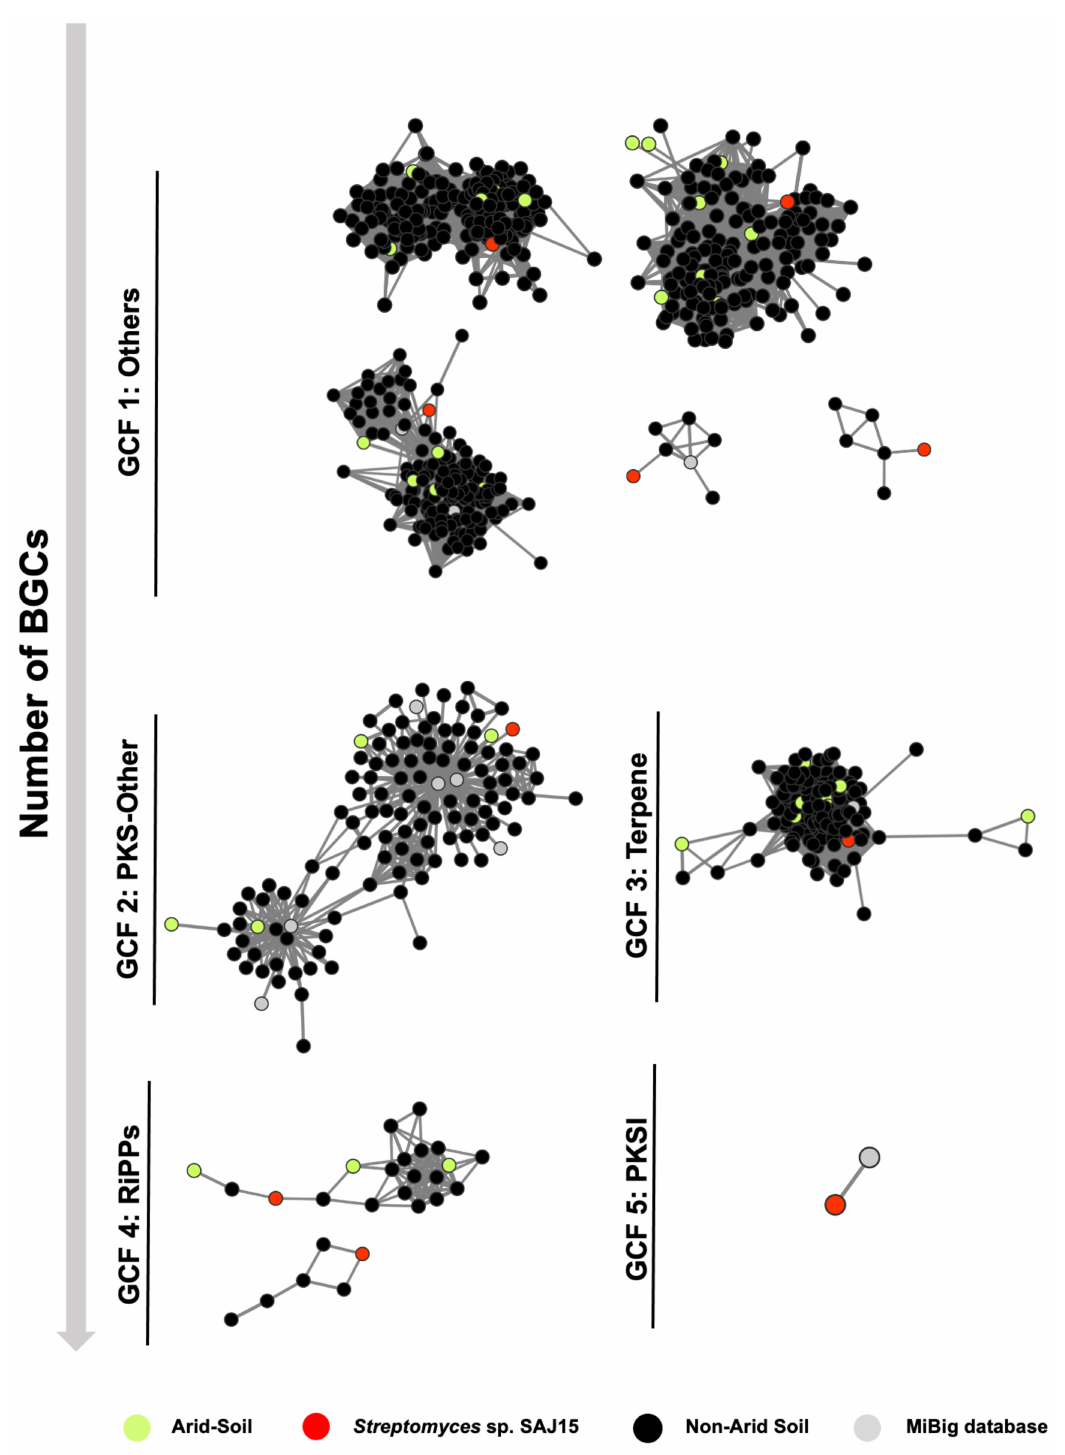
Figure 2. Simplified version of biosynthetic gene cluster (BGC) sequence similarity networks of BGCs from SAJ15 using 179 Streptomyces genomes. In total, 6556 Streptomyces -BGCs were classified into BiG-SCAPE families (GCFs). Only ten BGCs from SAJ15 were found in the five GCFs. Most of the BGCs from arid-soil were found in gene cluster clans (GCC) with less than six Streptomyces -BGCs, suggesting poor distribution and specificity within the genus Streptomyces (Supplementary Figures